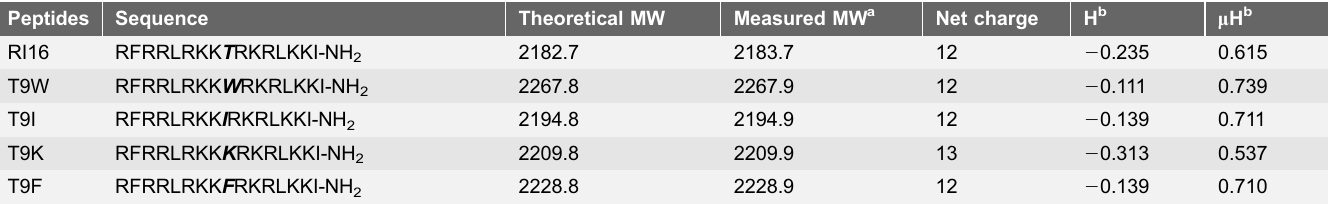
Table 1. Key physicochemical parameters of parental and mutant